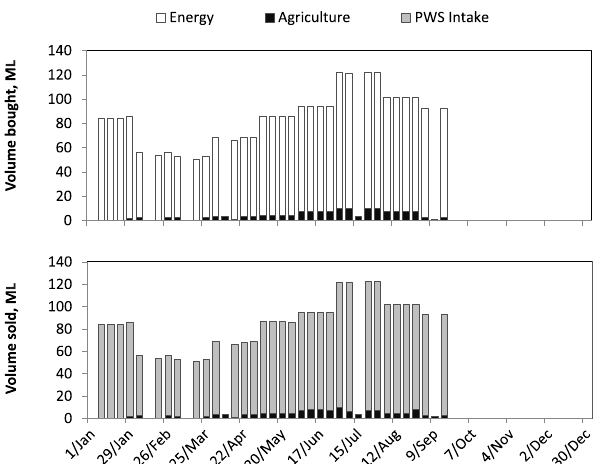
Figure 6. Water volumes bought (top panel) and sold (bottom panel) in millions of litres per week by sector under the proposed (scalable) licensing